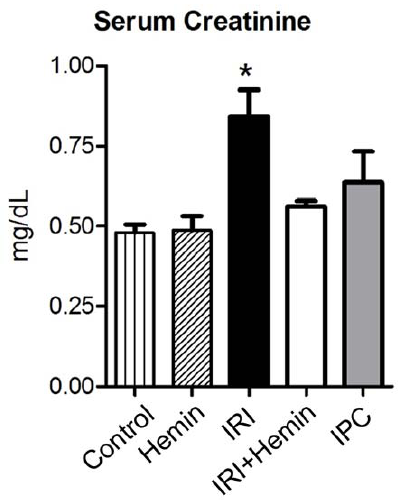
Figure 1. Mean ± standard deviation of serum creatinine concentrations found in mice submitted to different experi- mental manipulations. C57BL/6 male mice were subjected to surgical and treatment procedures as per described in Materials and Methods. Levels of serum creatinine were measured using the modified Jaffe´ technique. *Groups were statistically compared using ANOVA followed by Tukey’s post hoc test with p , 0.05.